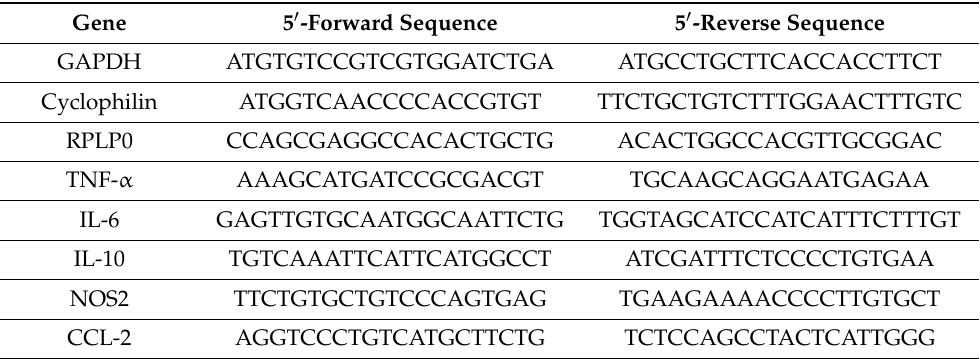
Table 1. Primer sequences used in quantitative polymerase chain reaction (qPCR) reactions. Gene 5 (cid:48) -Forward Sequence 5 (cid:48) -Reverse